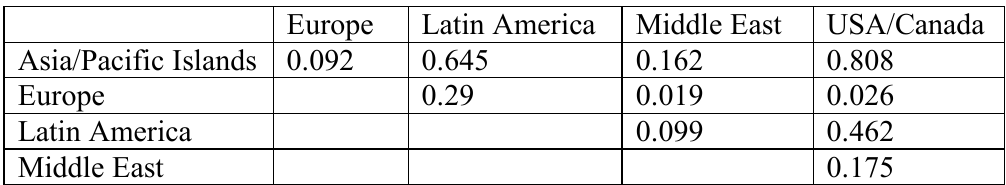
Table A3.5. GLMM model results for pairwise comparisons examining differences in crop plant richness based on region of national origin. Numbers show p-values for pairwise comparisons of different levels for reach factor.